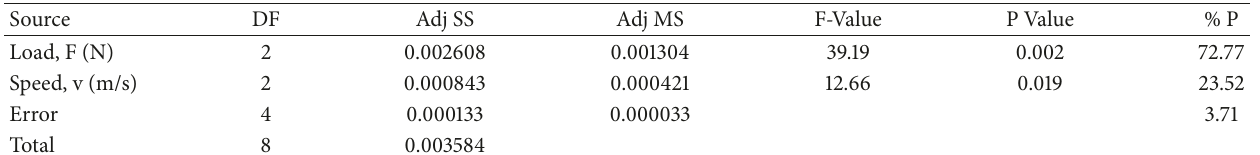
Table 4: ANOVA for coefficient of friction.